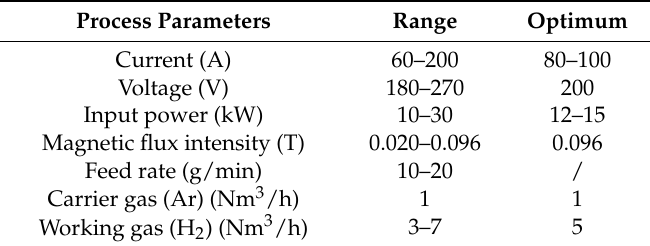
Table 1. Operating parameters of plasma reactor.